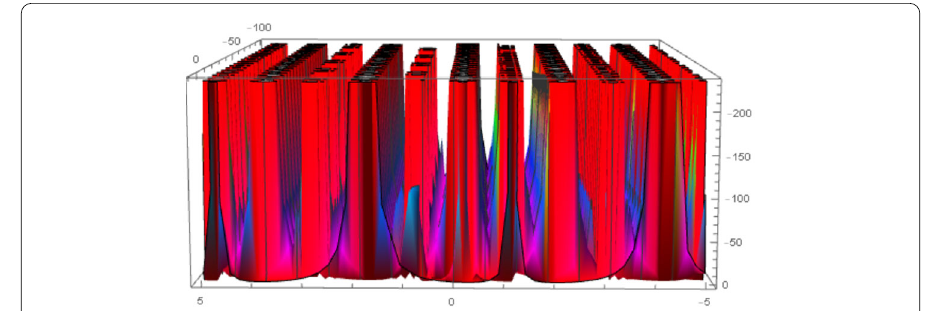
Figure 1 Periodic wave profile of u 1 ( η ) for α = 0.2, a 1 = 11, λ = 1, V = 12, b 0 = 1, b 1 = 12